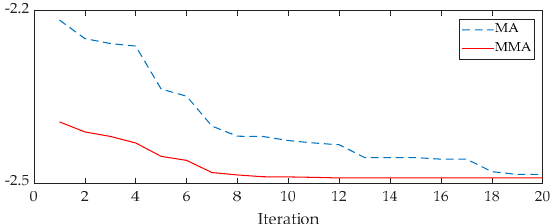
Figure 18. The results of each iteration for the ball fault signal: red line for the MMA and blue line for the raw MA.